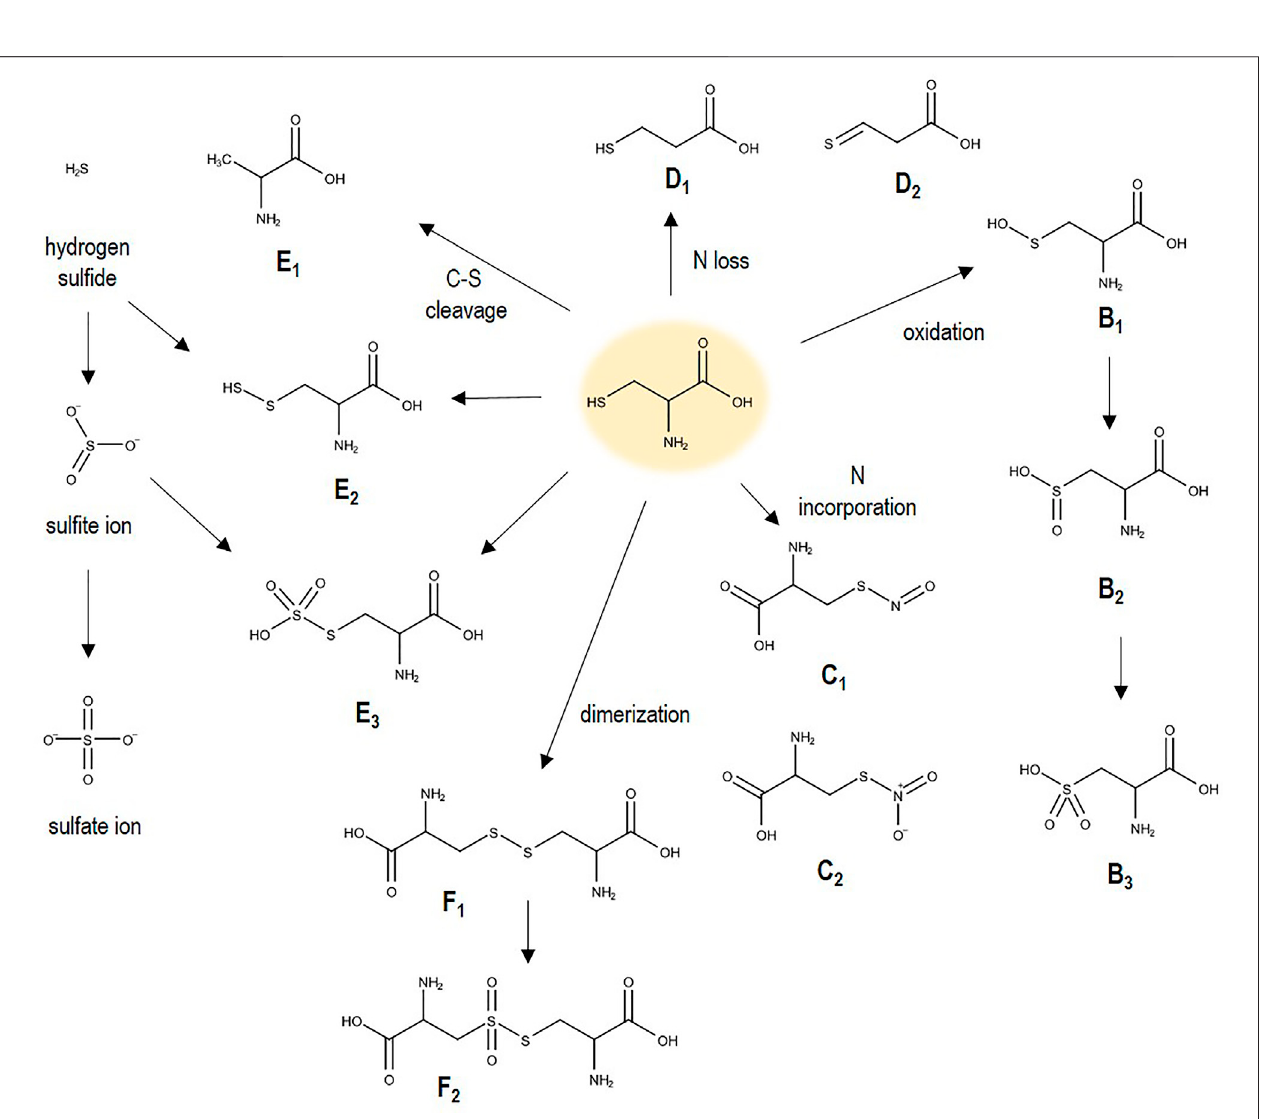
FIGURE 2 | Cysteine oxidation and cleavage products (see Tables 1 , 2 ). When incorporated into a protein, the carboxyl and amino group are incorporated in the peptide bond.